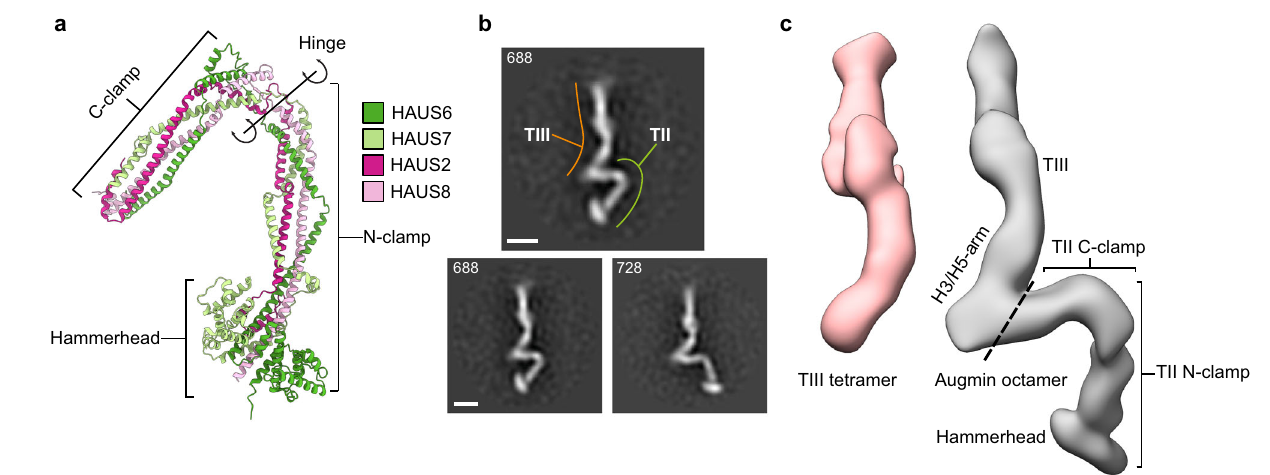
c Negative stain 3D reconstructions of the isolated TIII tetramer (red) and the augmin holocomplexin one of two main conformations (grey).Structural features areannotatedandtheboundarybetweenTIIandTIIIintheaugminholocomplexis indicated (dashed